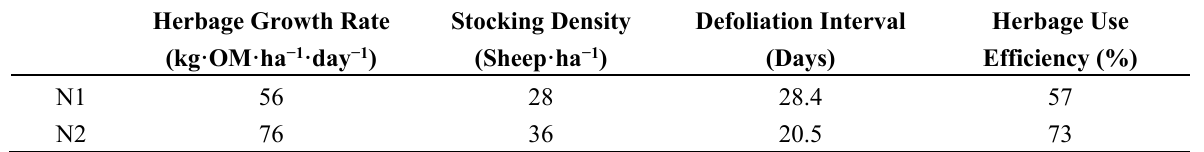
Table 1. Comparison of herbage growth and herbage use efficiency of two tall fescue swards maintained at similar LAI in a continuous stocked system and receiving either a non-limiting N supply (N2) or a deficient N supply (N1). After